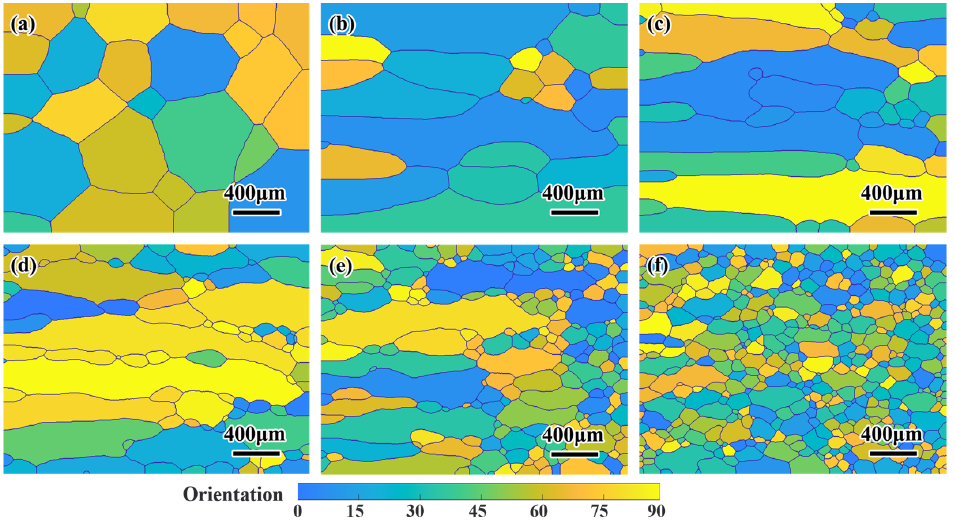
Figure 7. Simulated microstructures with various drawing velocities after directional annealing at 900 °C. ( a ) 0.1 μ m/s, ( b ) 0.75 μ m/s, ( c ) 3.75 μ m/s, ( d ) 7.5 μ m/s, ( e ) 18 μ m/s, ( f ) 30 μ m/s.